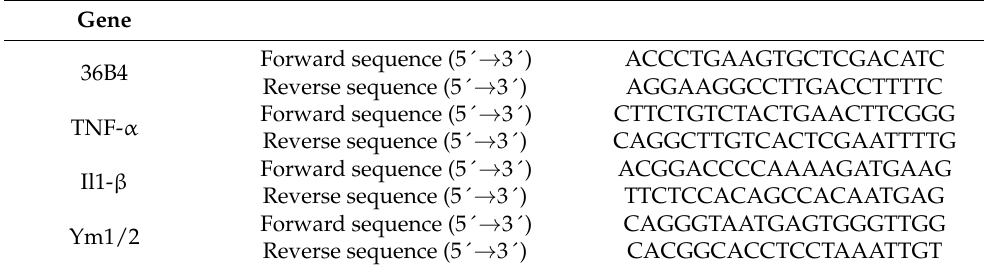
ACCCTGAAGTGCTCGACATC AGGAAGGCCTTGACCTTTTC